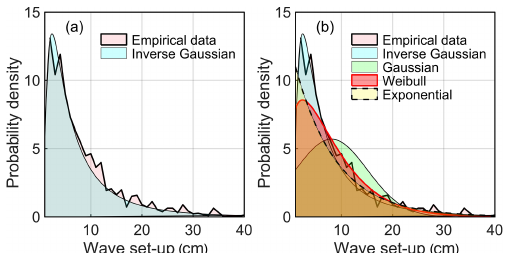
Figure 11. (a) The best fit of the data set presented in Fig. 8 in the range of 0.01–0.4m with an inverse Gaussian distribution (with mean µ = 0 . 0804 ± 0 . 0004m and shape parameter λ = 0 . 0793 ± 0 . 0005). (b) The best fit of the same data set with exponential (rate 12 . 44 ± 0 . 06m − 1 ), Gaussian (mean 0 . 0804 ± 0 . 0003m, SD 0 . 0700 ± 0 . 0002m), and Weibull (shape parameter 1 . 247 ± 0 . 004, scale parameter 0 . 0867 ± 0 . 0003m) distributions is also shown.